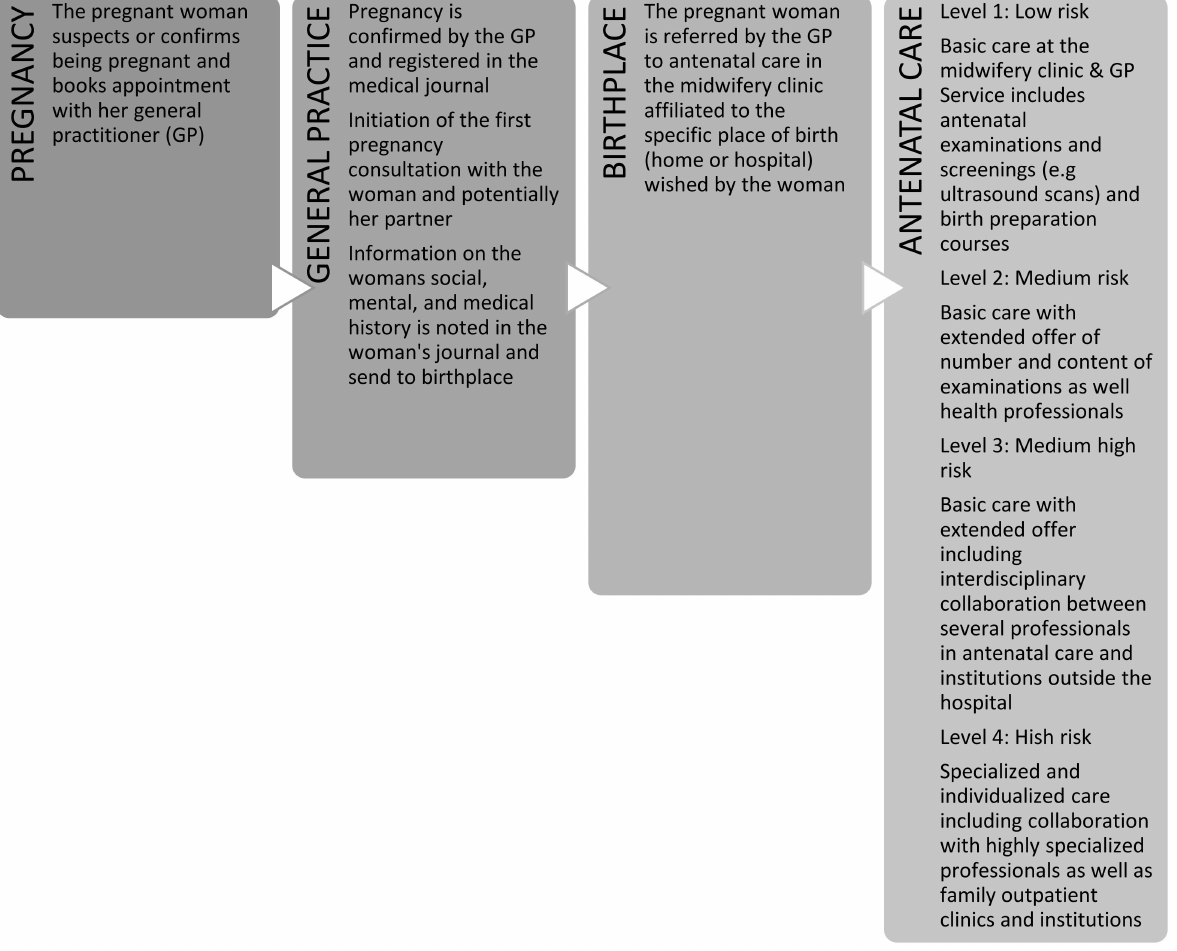
Figure 1. Organization of Danish antenatal